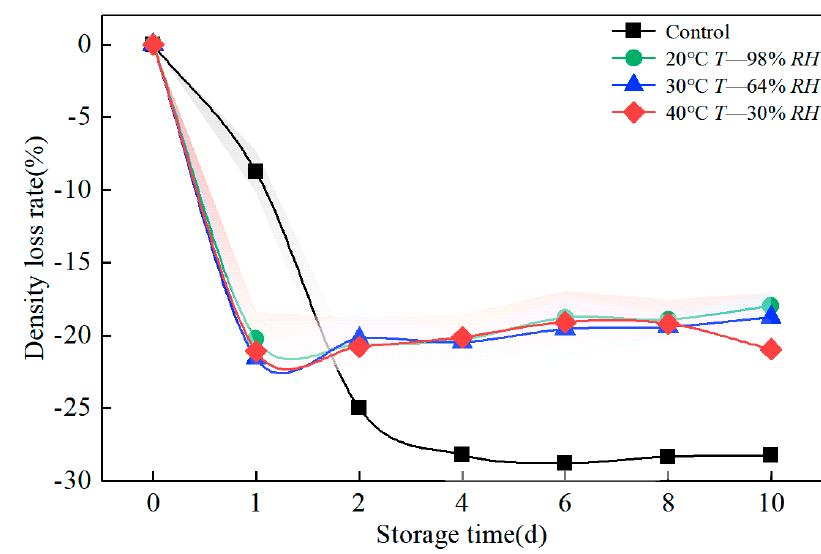
Figure 5. Effect of humidity and heat ageing on the density of bamboo.